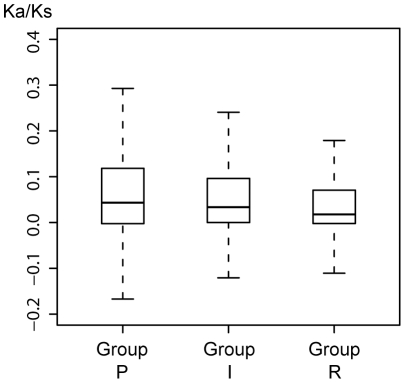
Comparison of Ka/Ks between different gene groups in SDY.The Ka/Ks was adjusted following Methods. Group P, Pseudogenes; Group I, the Intact genes in the decayed-operons; Group R, the Rest functional genes in the genome.